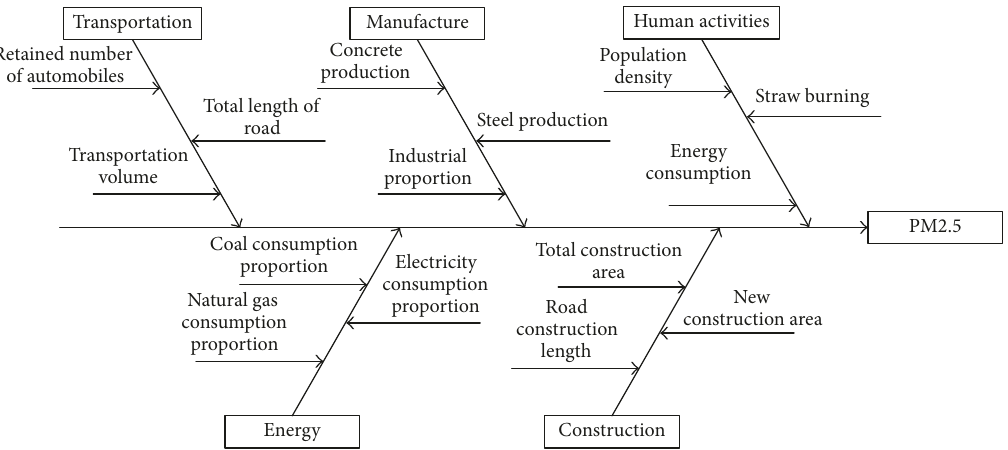
Figure 4: Influencing factors of